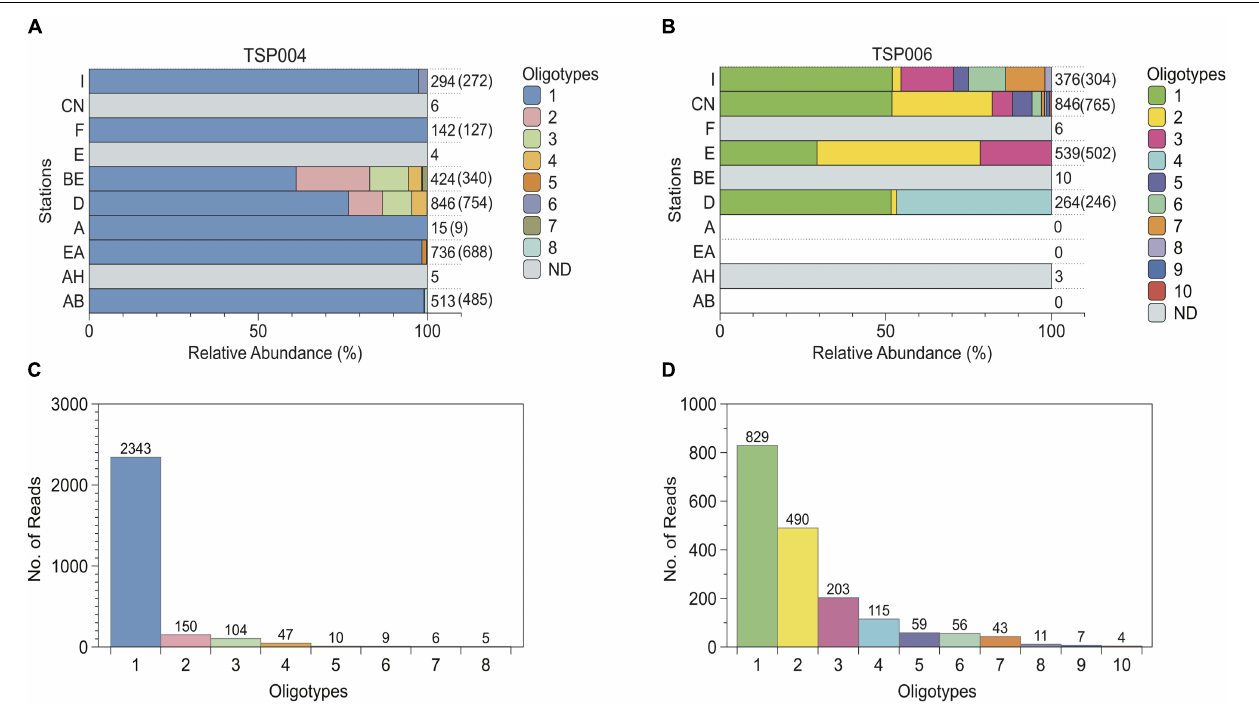
FIGURE 4 | Distribution and relative abundances of oligotypes within Desulfotomaculum OTUs TSP004 (A,C) and TSP006 (B,D) . (A,B) Numbers to the right indicate the total number of reads detected in each station, followed in parentheses by the number of reads retained in the final oligotyping analysis. “ND”, gray bars = not determined, i.e., oligotyping not performed due to low numbers of reads. White/blank indicates stations in which the OTU was not detected in pyrosequencing libraries. Sampling stations are ordered in approximately northern-most to southern-most on the y -axis. (C,D) Rank-abundance showing number of sequence reads per observed oligotype. For all panels, different colors represent different oligotypes; oligotyping results based on the shorter alignment for TSP004 are shown. TABLE 3 | Results for Analysis of Molecular Variance (AMOVA) and RELATE tests on oligotype composition for three Desulfotomaculum OTUs. Abundance (Bray-Curtis) Presence-Absence (Jaccard) AMOVA a Geographic distance b Water depth b Geographic distance b Water depth